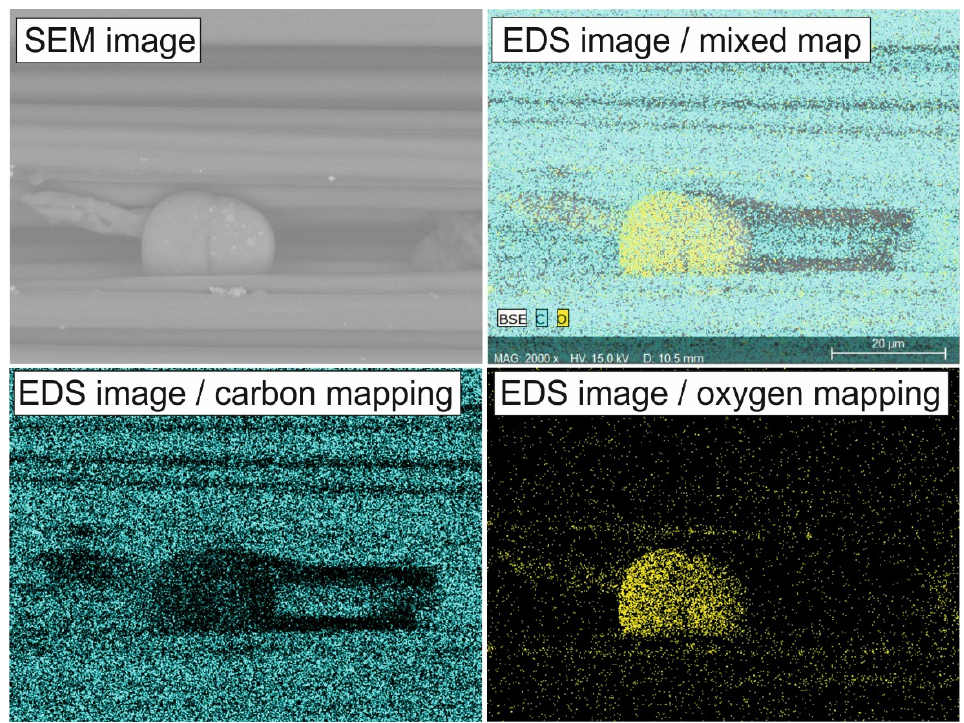
Figure 33. SEM image and related EDS images from fabric from carbon fibers (Sigratex Fabric KDK) recorded in higher magnification. The mappings for chemical elements carbon and oxygen are especially compared.